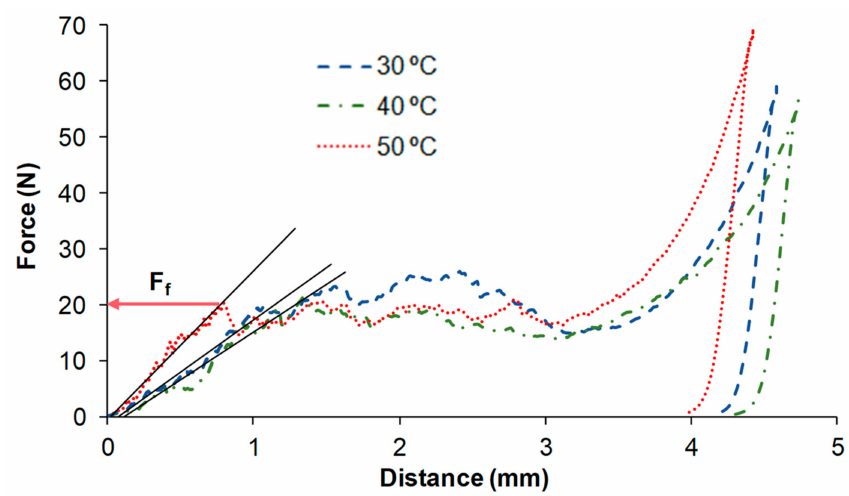
Figure 3. Examples of force–distance curves obtained from the freeze-dried purees frozen at a slow rate and freeze-dried at 5 Pa, and with di ff erent shelf temperatures (30, 40 and 50 ◦ C). F f : fracture force. Values of the slope 18–26 N / mm were obtained when heating the freeze-drier shelves to 50 as compared to 11–18 N / mm values obtained at 30 and 40